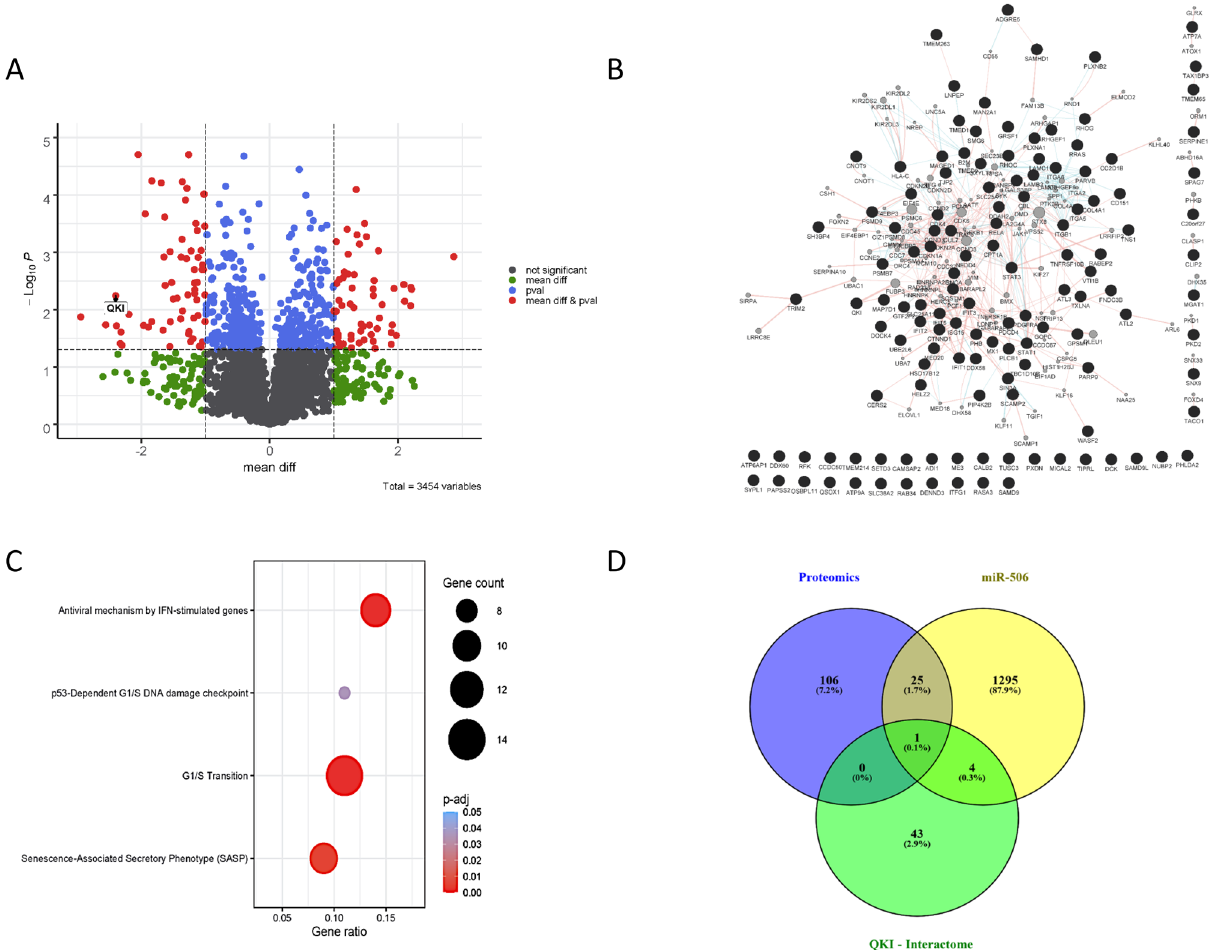
Figure 4. ( A ) Volcano plot of proteomics analysis after MRC5 treatment with miR-506. ( B ) Interaction network from proteomics. The 132 deregulated proteins of the miR-506-modulated proteomics resulted in a miR-506-proteome-interactome of 229 nodes and 578 edges. Nodes represent an interaction partner, edges represent interactions. ( C ) Functional enrichment analysis of proteomics data. Bubble size illustrates the ratio between the proteins connected to a process and the overall query size. Color scaling according to the adjusted p -value (Supplementary Table 1 for whole functional enrichment analysis using g:Profiler). ( D ) Mapping of